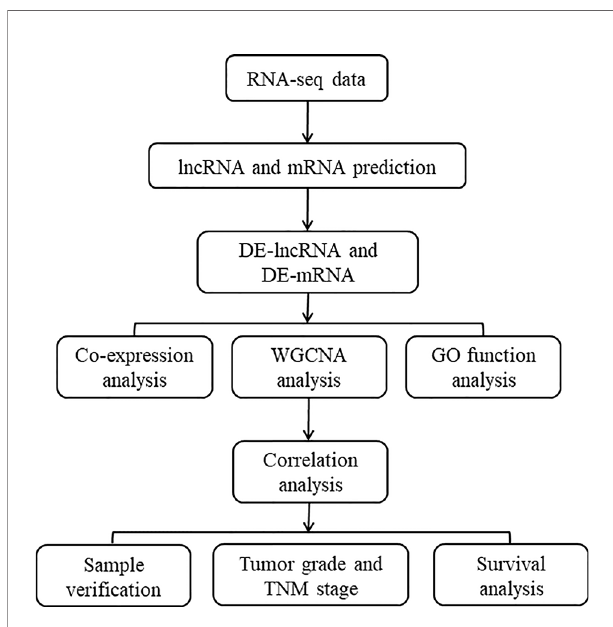
FIGURE 1 | Flowchart of the